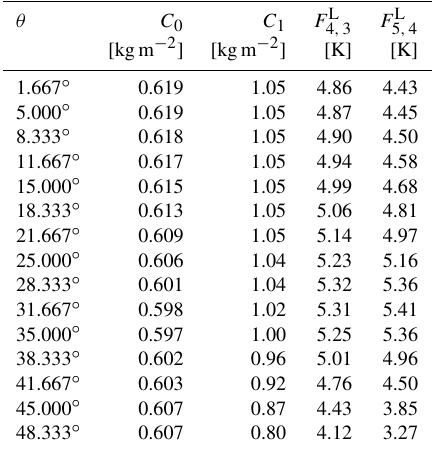
Table A1. Calibration parameters for the Arctic low-TWV algo- rithm.